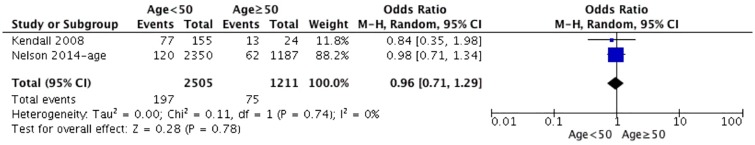
Correlations between age and complications.